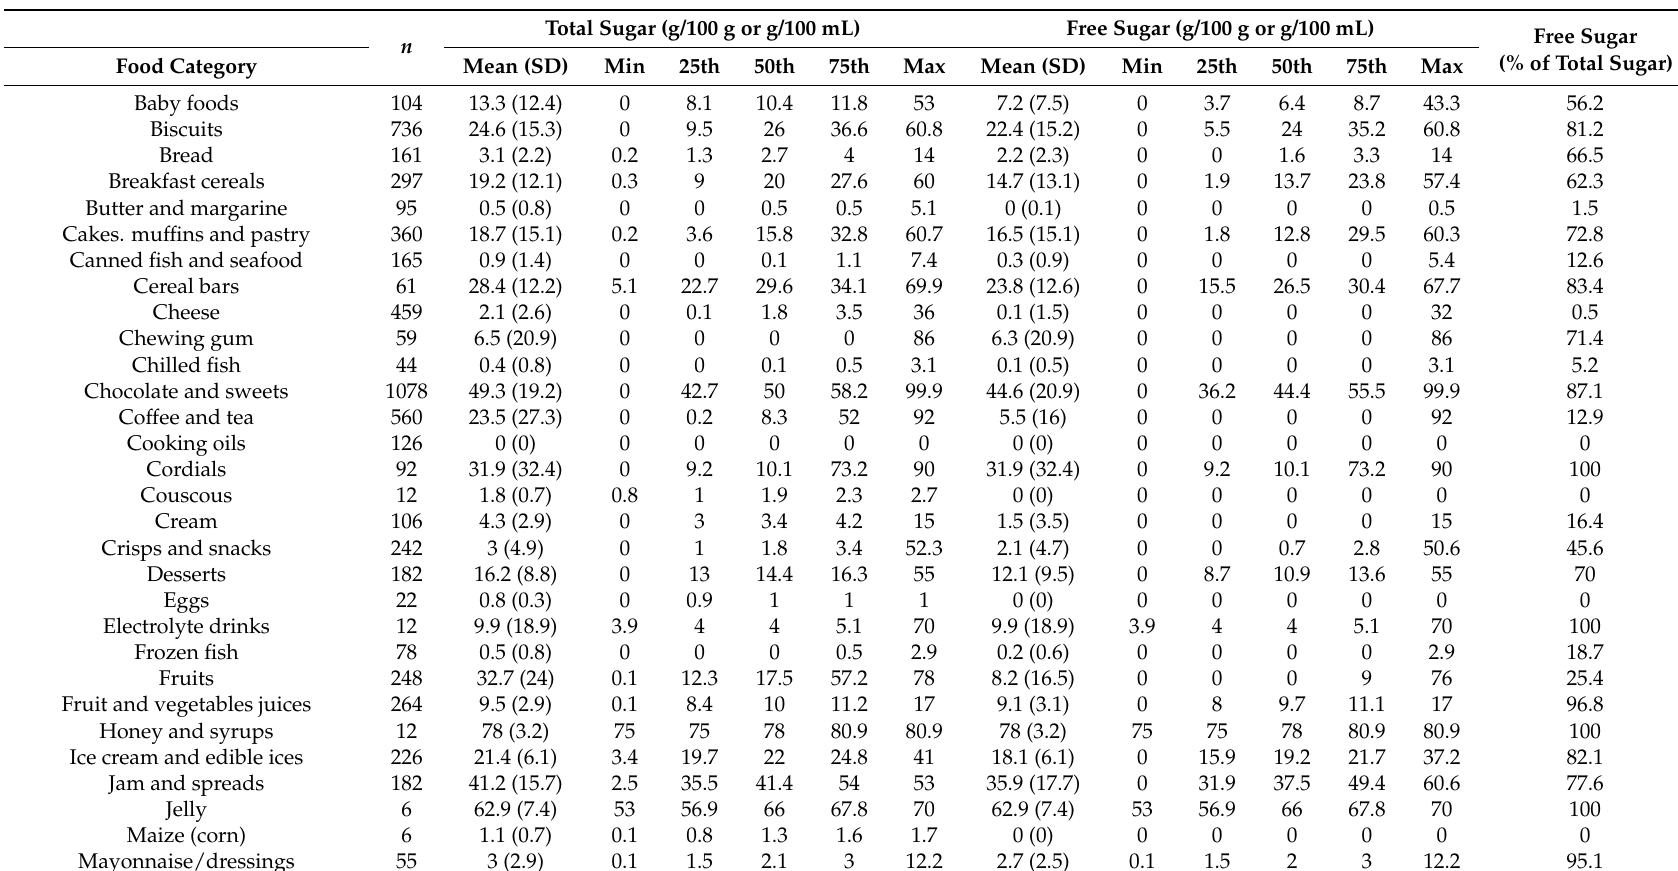
Table 2. Total and free sugar content (g/100 g or g/100 mL) of 10,407 packaged food products divided by food categories. Mean values, SD, quartiles (min, 25th, 50th/median, 75th, max), and mean free sugar as a proportion of free sugar are shown for each